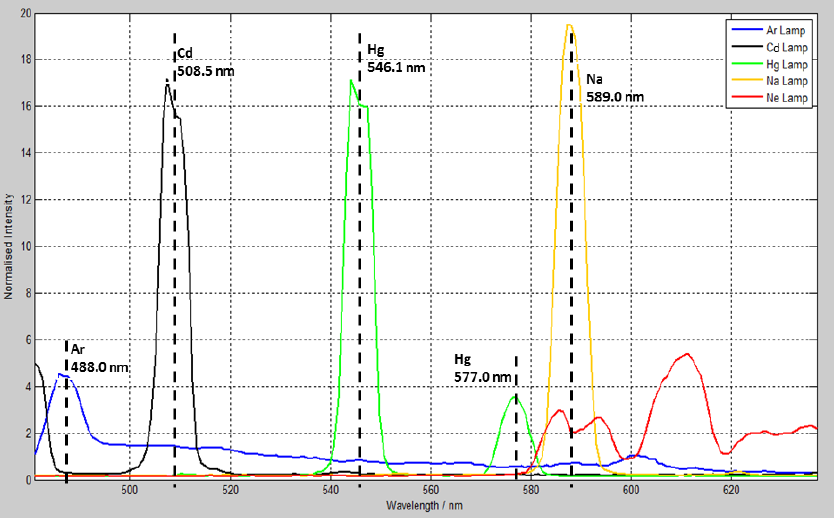
Figure 10. Spectral profiles extracted from five lamps, showing the sodium 589.0/589.6 nm doublet and the Hg lines at 546.1 nm and 577.0/579.1